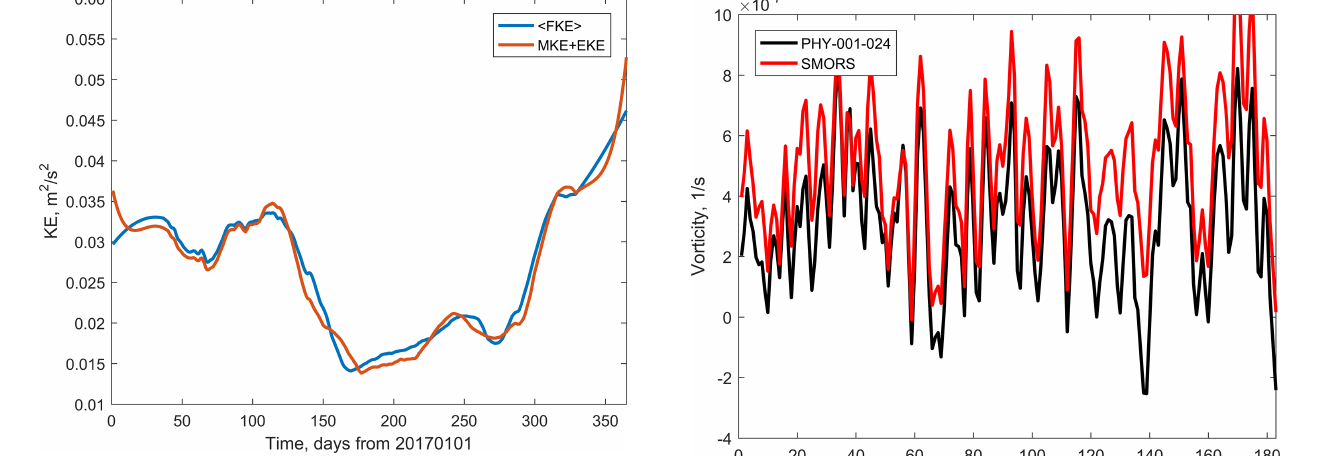
Figure 9. Temporal variability of area-averaged, time-smoothed full kinetic energy (blue) and the sum of eddy and mean kinetic energy (orange) in the surface layer of the Red Sea during 2017.